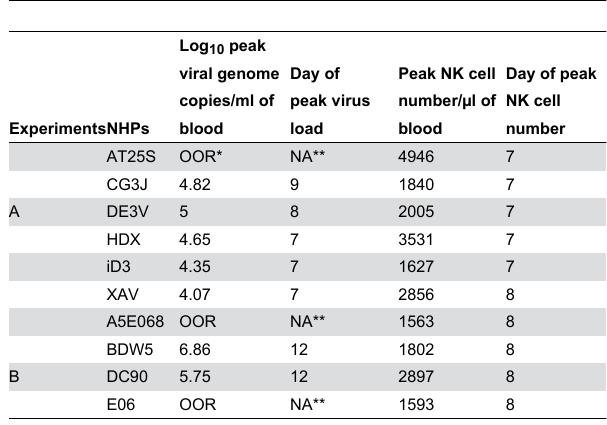
Table 2. Peak virus load and peak NK cell number in the circulating